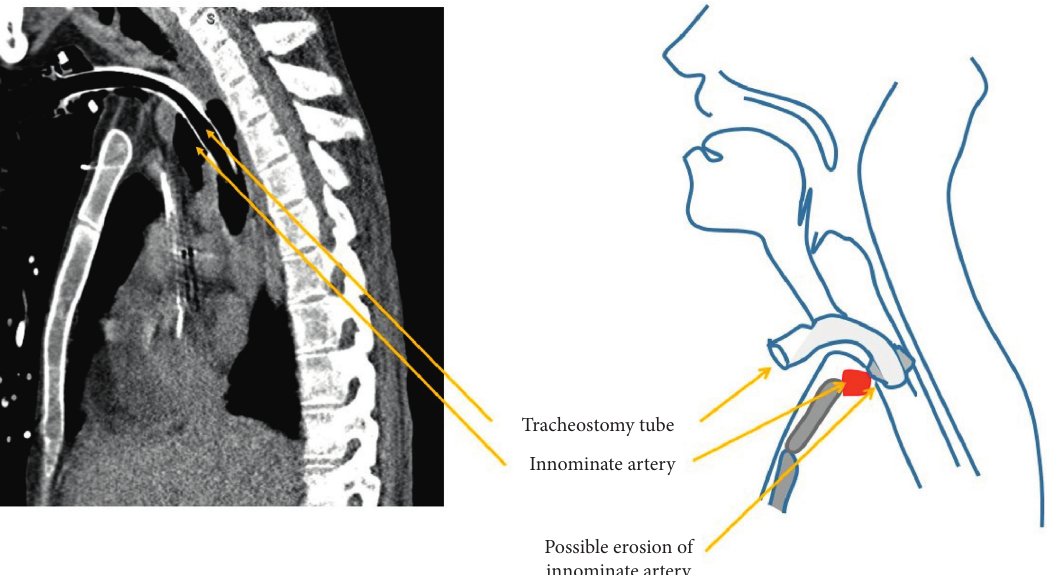
Figure 1: Pressure necrosis from tracheostomy cuff can erode innominate artery to form a trachea-innominate fistula. (a) Computed tomographic scan of this patient showing close proximity of the innominate artery to the tracheostomy tube. (b) Schematic diagram of the anatomical relationships in the formation of a fistula between the trachea and the innominate